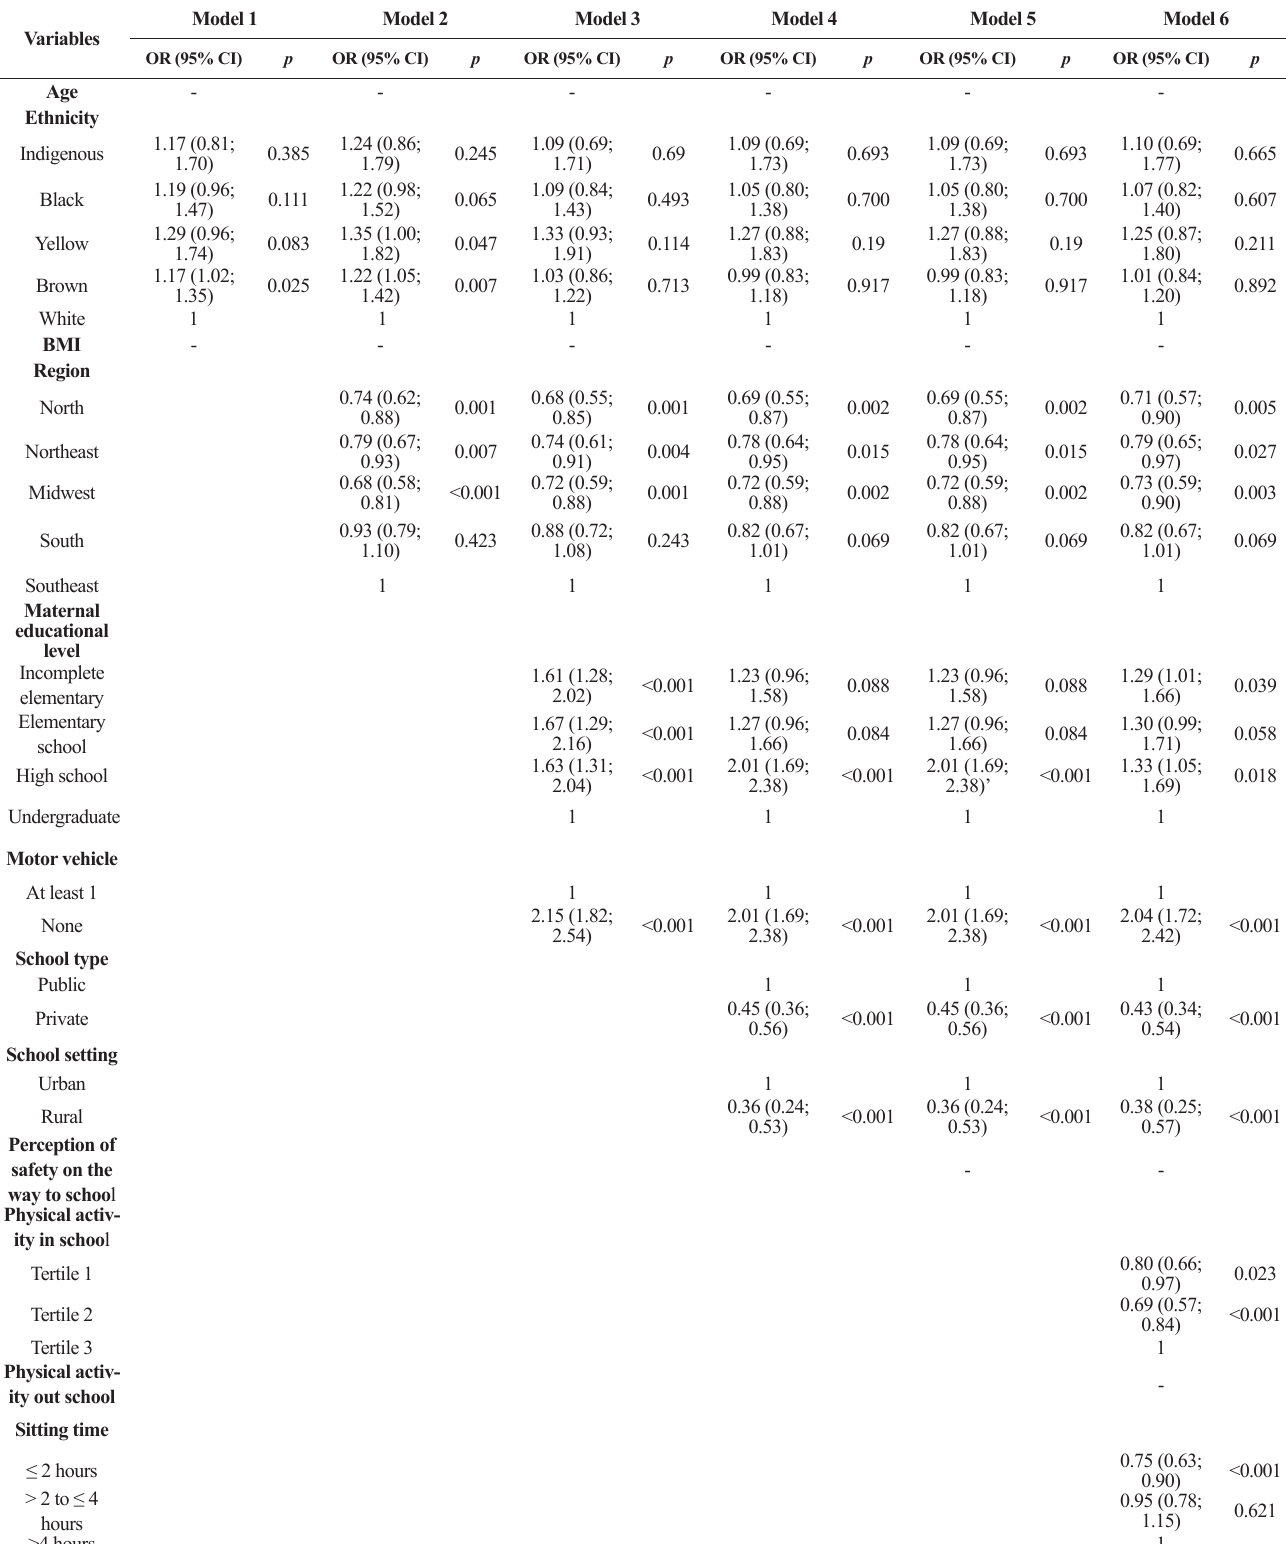
Table 3 - Adjusted logistic models for correlates of active commuting to schools in